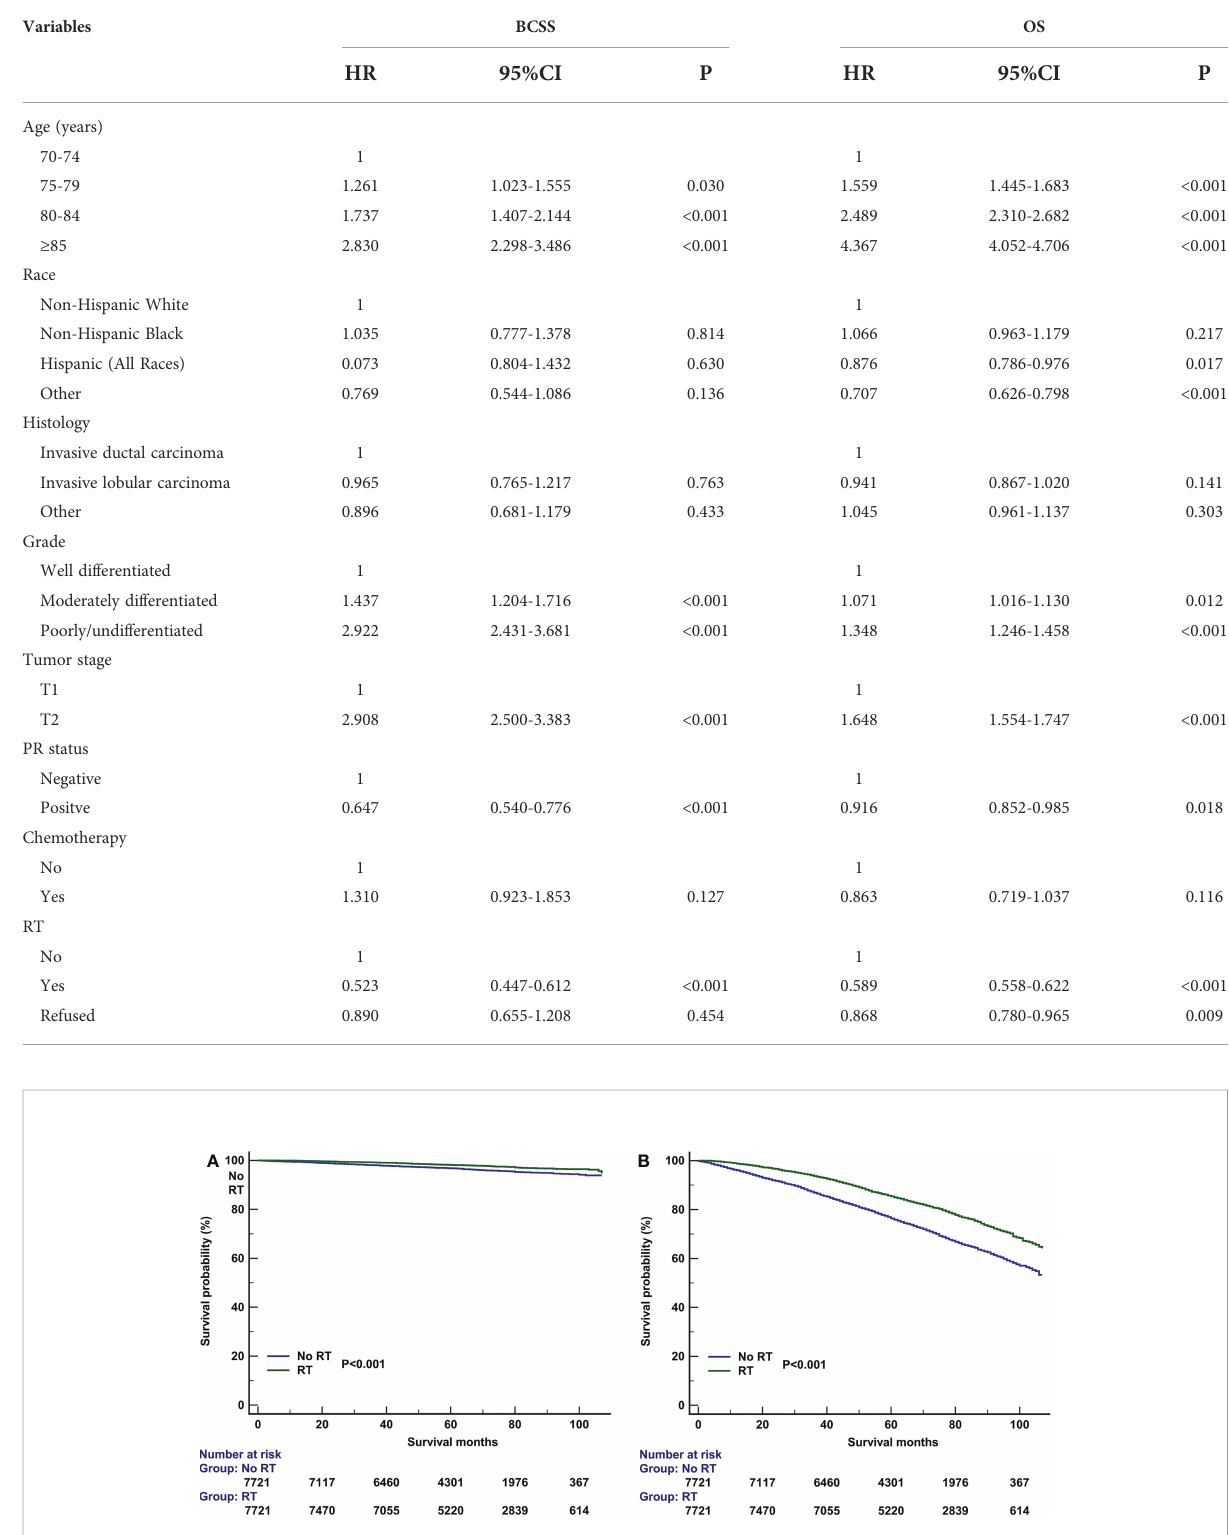
TABLE 2 Multivariate prognostic analysis before propensity score matching.